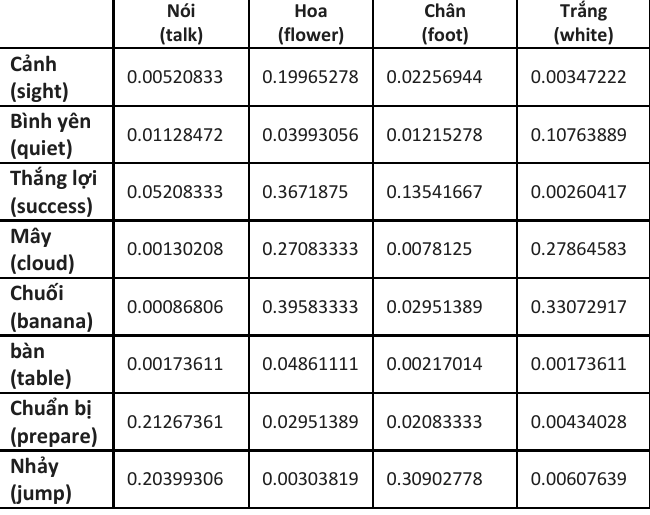
Table 3. Co - occurrences words with